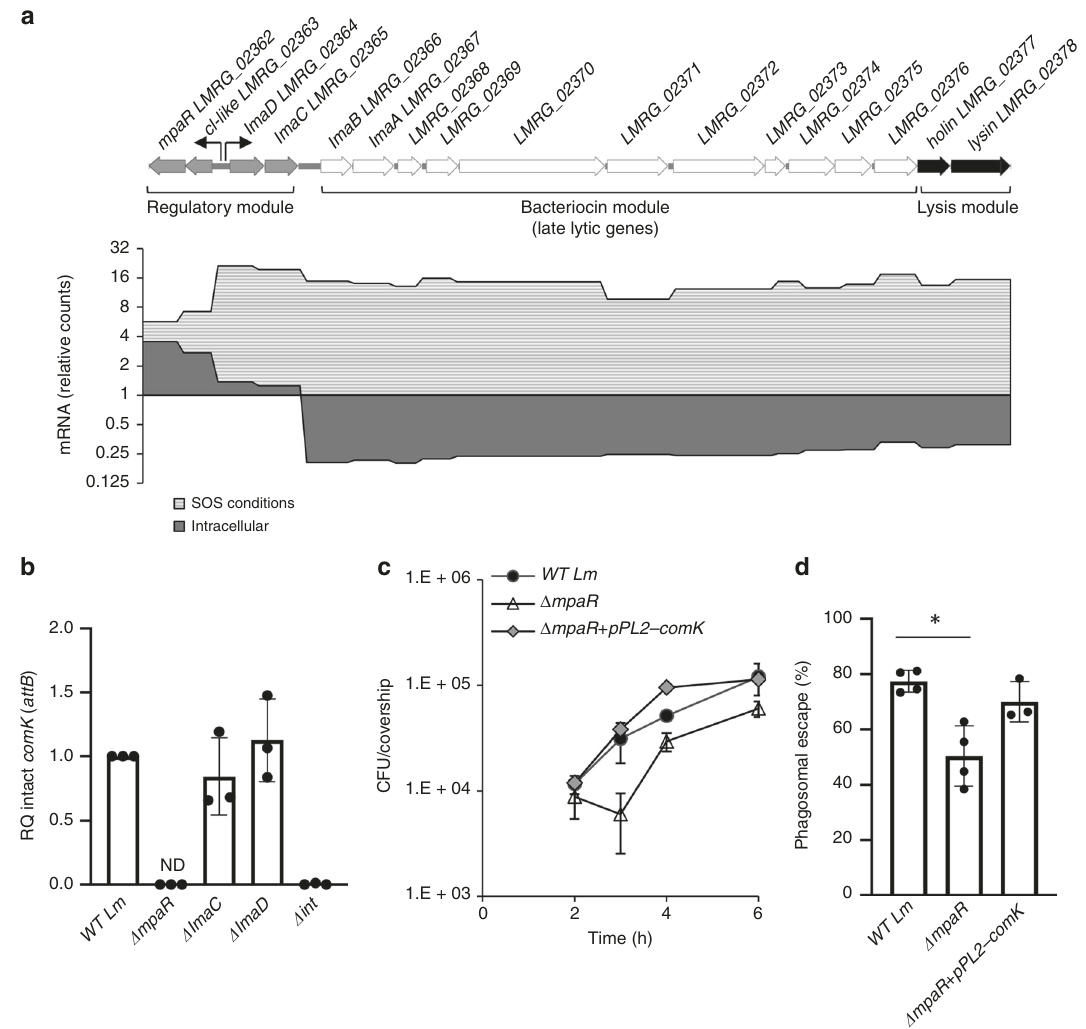
Fig. 3 MpaR is required for ϕ 10403S excision. a Upper panel: schematic representation of the monocin locus. The mon consists of 17 genes comprising: a regulatory module, a bacteriocin module encoding tail-like structures, and a lysis module. Lower panel: transcription analysis of the monocin cluster genes under SOS and intracellular growth (in BMDM cells) conditions, using NanoString technology. Transcription levels are presented as relative counts, relative to the levels observed at the lysogenic state (i.e., exponentially grown bacteria in BHI medium at 37 ˚ C). Data represent three independent experiments. b qRT-PCR analysis of intact comK gene (representing ϕ 10403S attB site) in WT Lm and indicated mutants grown intracellularly in BMDM cells (6 h post infection). Presented as relative quantity (RQ), relative to the levels in WT bacteria. The data is a mean of three independent experiments. Error bars indicate a standard deviation. c Intracellular growth analysis of WT Lm , Δ mpaR and Δ mpaR mutant complemented with an intact comK gene under its native promoter ( Δ mpaR + pPL2- comK ). Growth curves represent one biological replicate, more independent experiments are shown in Supplementary Fig. 2 and in the source fi le. Error bars represent standard deviation of triplicate samples, sometimes are hidden by the symbols. d A bacterial phagosomal escape assay. Percentage of bacteria that escaped the macrophage phagosomes at 2.5 h post infection, as determined by a microscope fl uorescence assay. Macrophages were infected with WT Lm , Δ mpaR and Δ mpaR mutant complemented with an intact comK gene on the pPL2 plasmid ( Δ mpaR + pPL2 -comK ). The data is a mean of three independent experiments. The error bar represent standard deviation. Asterisk (*) indicates statistical signi fi cance of p < 0.01 calculated using Student's t -test. Source data are provided as a Source Data fi